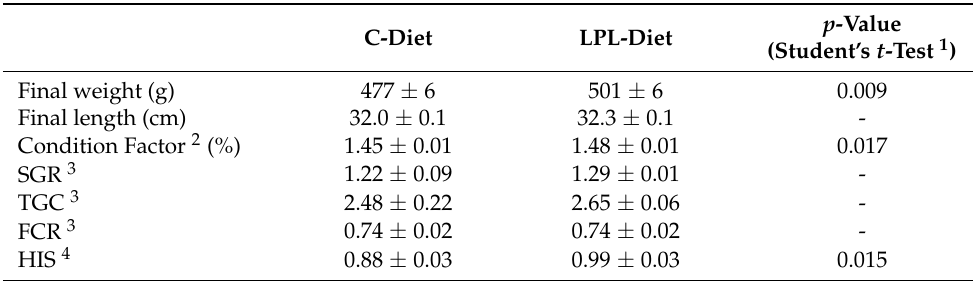
Table 1. Growth performance of Atlantic salmon fed with control diet (C-diet) and lysophospholipid- enriched diet (LPL-diet).